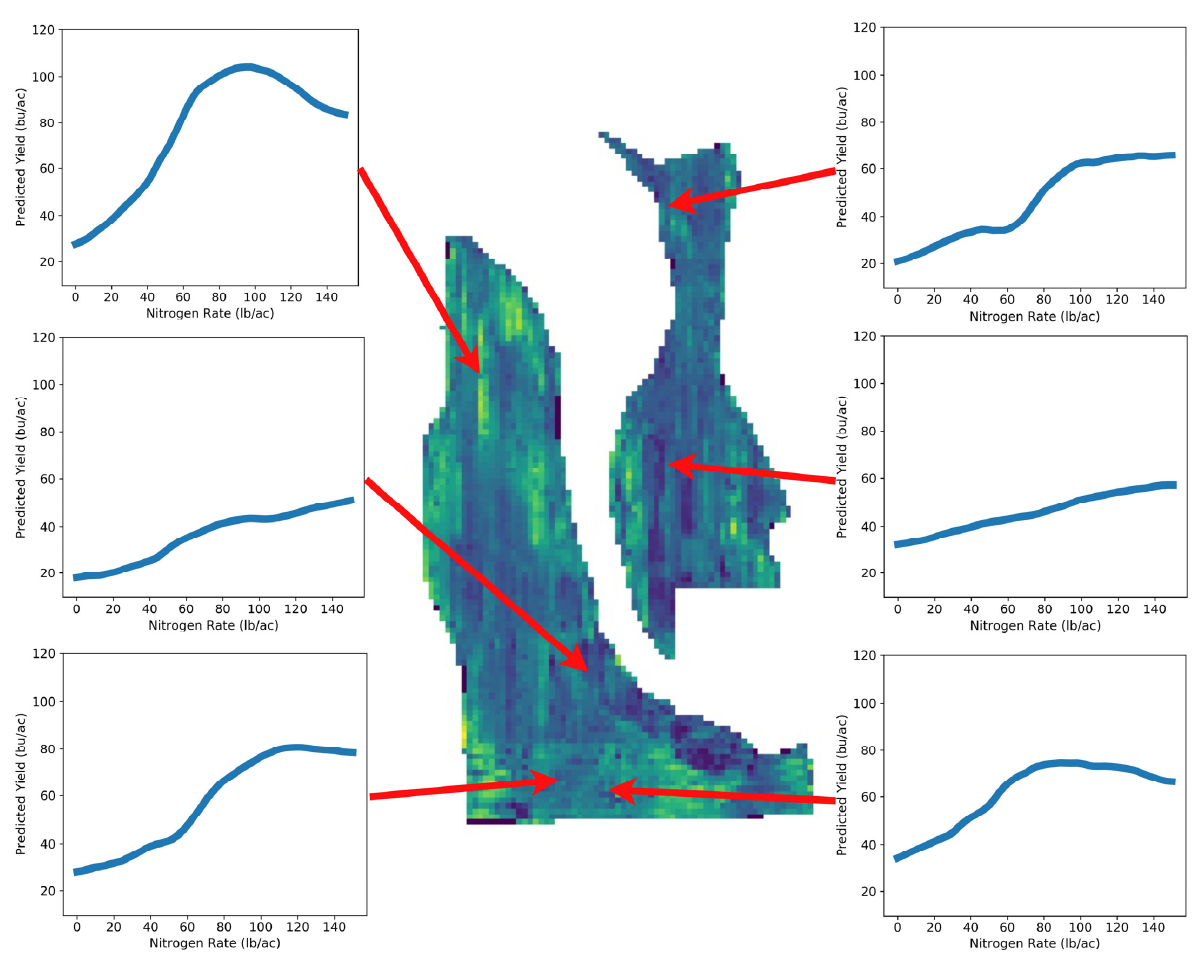
Figure A1. Example of the type of N-response curves generated for different regions of a rain-fed winter wheat field.